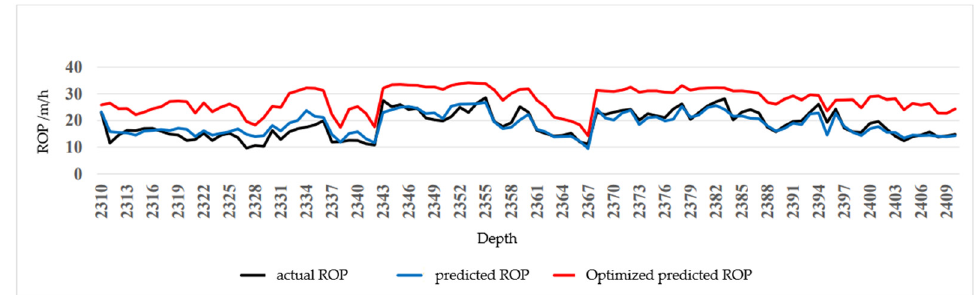
Figure 22. Optimization results of drilling parameters.